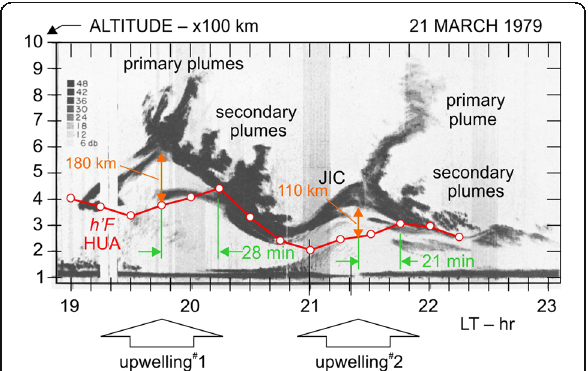
Fig. 2 A composite of an altitude-time-intensity plot of F -region backscatter obtained with the JIC radar, shown with a grayscale, and h ’ F versus LT, which were scaled at 15 min intervals from HUA ionograms; 21 March 1979. The individual plots are from Kelley et al.